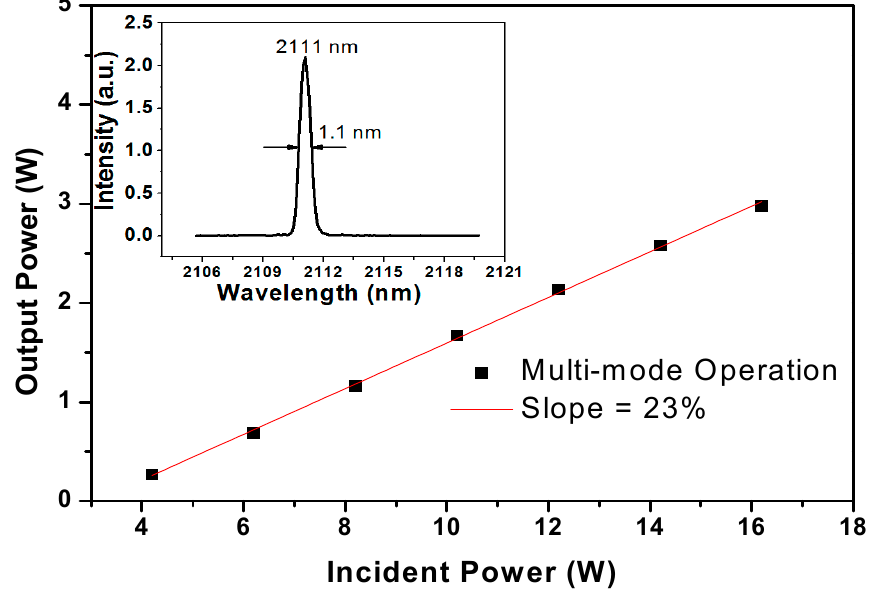
Figure 3. The performance of the multi ‐ mode Ho:SSO laser.